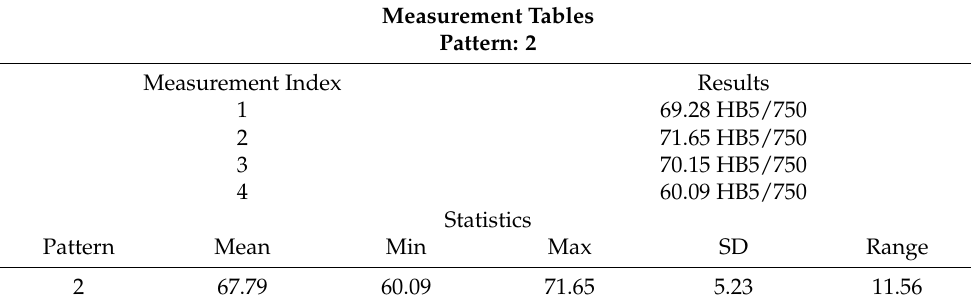
Table 4. Standard deviation, statistics, and post-cut hardness